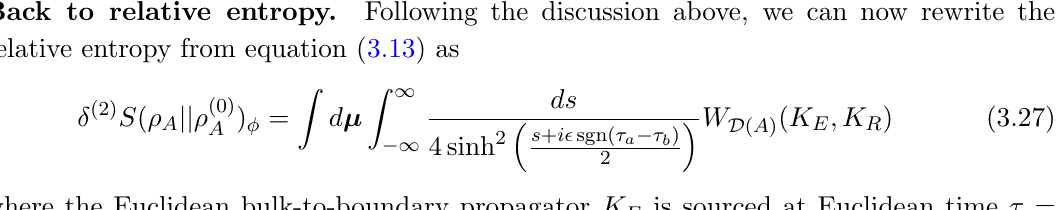
Figure 4 . The asymptotic symplectic (cid:13)ux evaluated on equal to the symplectic (cid:13)ux at the horizon r B Back to relative